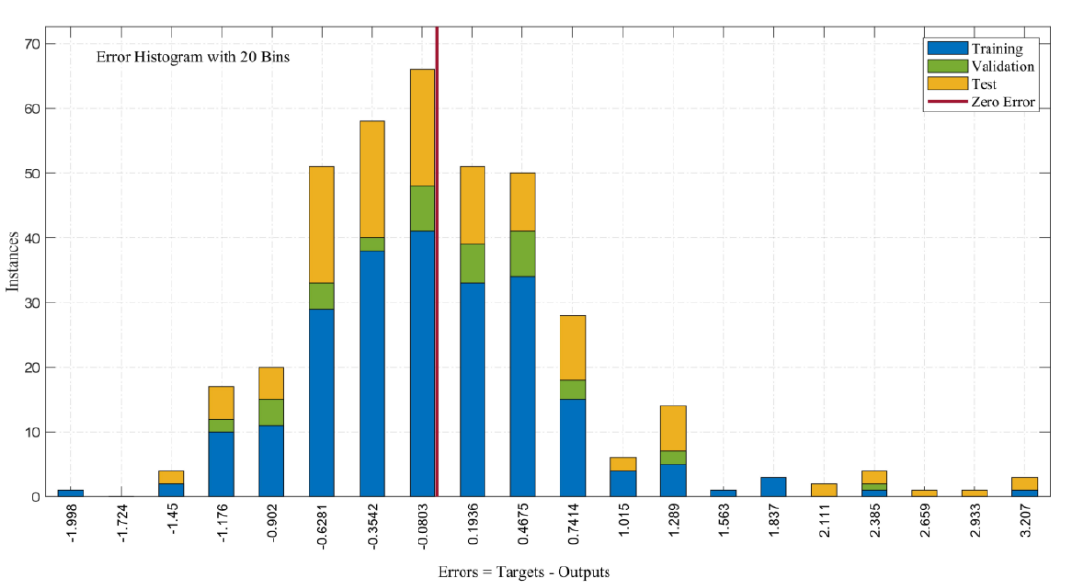
Figure 13. BR model error histogram.